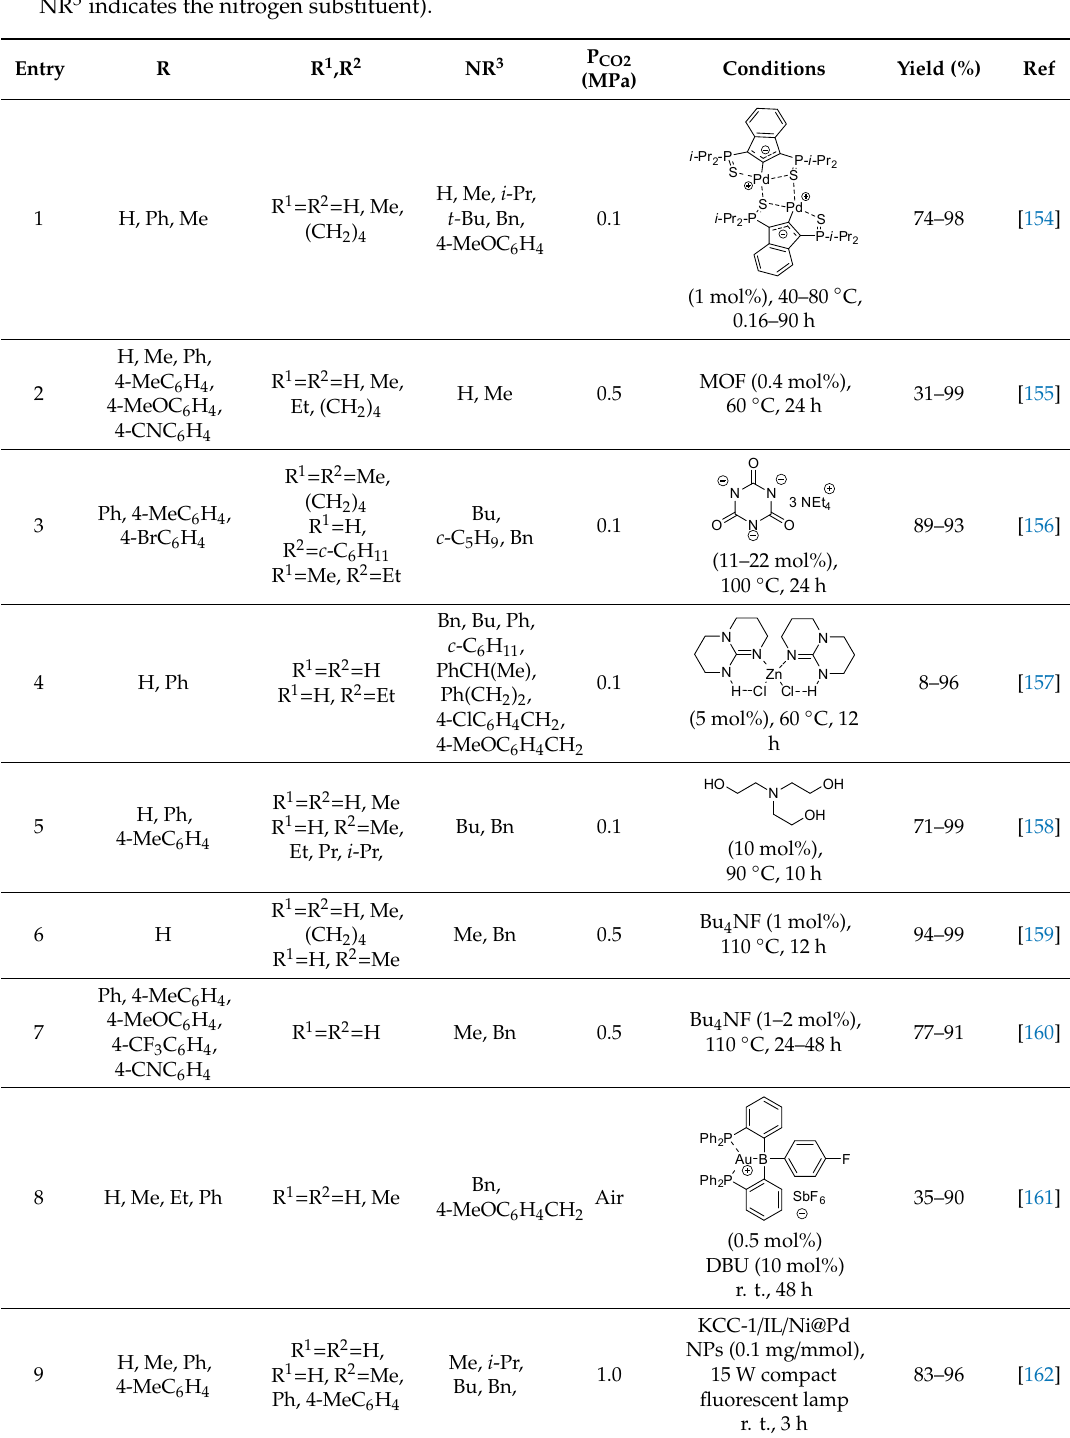
Table 4. Catalysts for the reaction of propargylamines and carbon dioxide (R, R 1 , R 2 see Scheme 14, NR 3 indicates the nitrogen substituent).